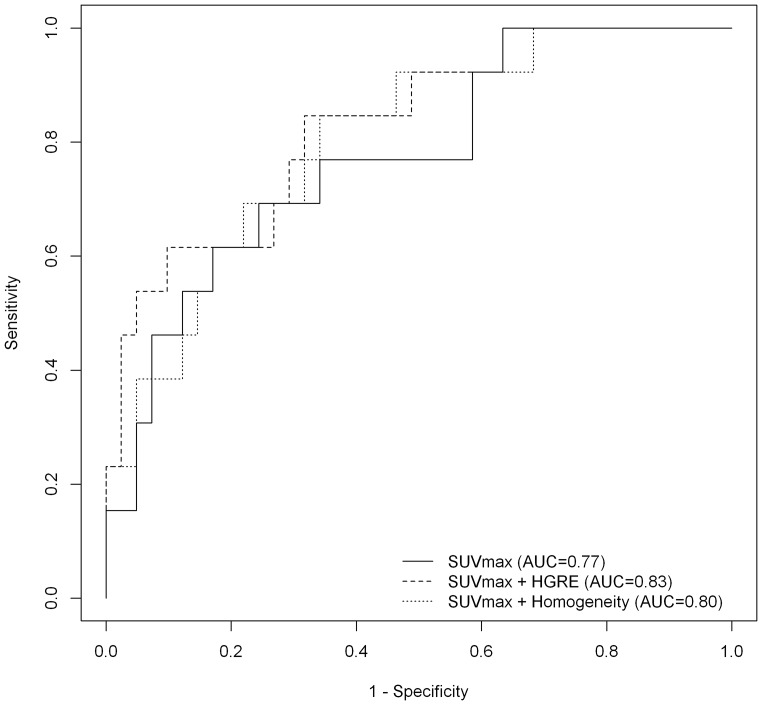
ROC curves analysis. AUC of SUVmax, SUVmax associated with homogeneity and SUVmax with HGRE for identifying TNBC.